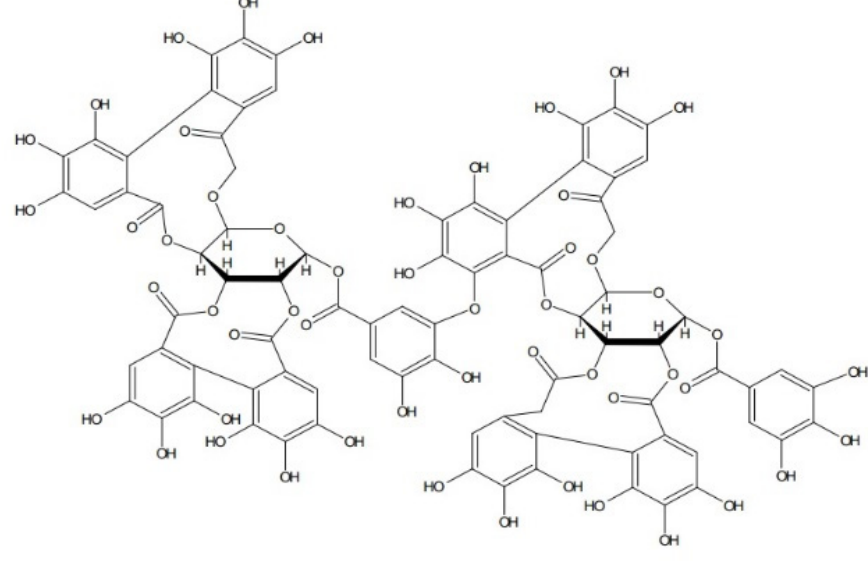
Figure 3. Sanguiin Figure 3. Sanguiin H-6.